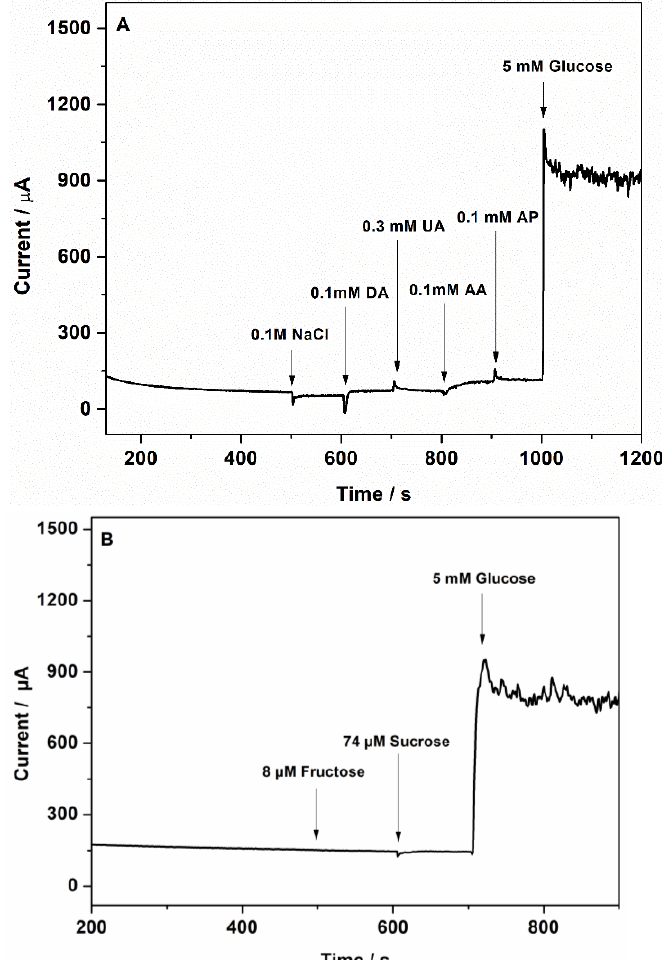
Figure 11. Amperometric responses of Au-CuNC to ( A ) 0.1 M sodium chloride, 0.1 mM dopamine, 0.3 mM uric acid, 0.1 Mm ascorbic acid, 0.1 mM acetaminophen, and 5 mM glucose in 50 mM NaOH and ( B ) 8 µM fructose, 74 µM sucrose, and 5 mM glucose in 50 mM NaOH.